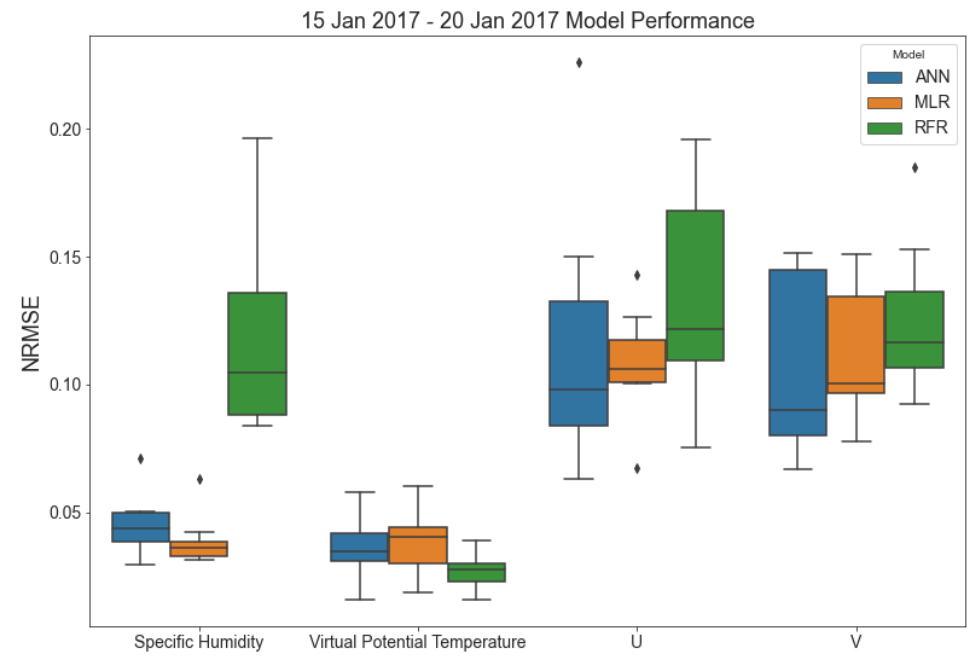
Figure A6. Same as Figure 3 but including the random forest model.